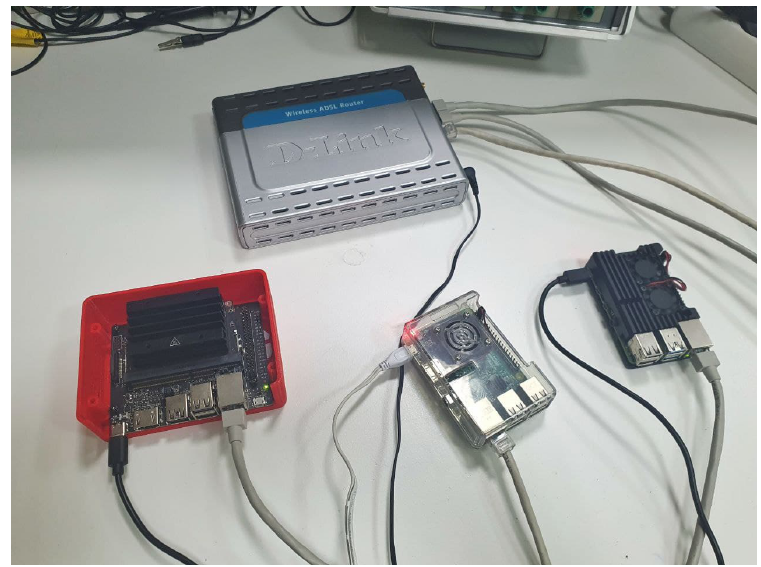
Figure 4. Marketplace-tested devices: up: switch; bottom-left: JNano; bottom-middle: RPi3; bottom- right: